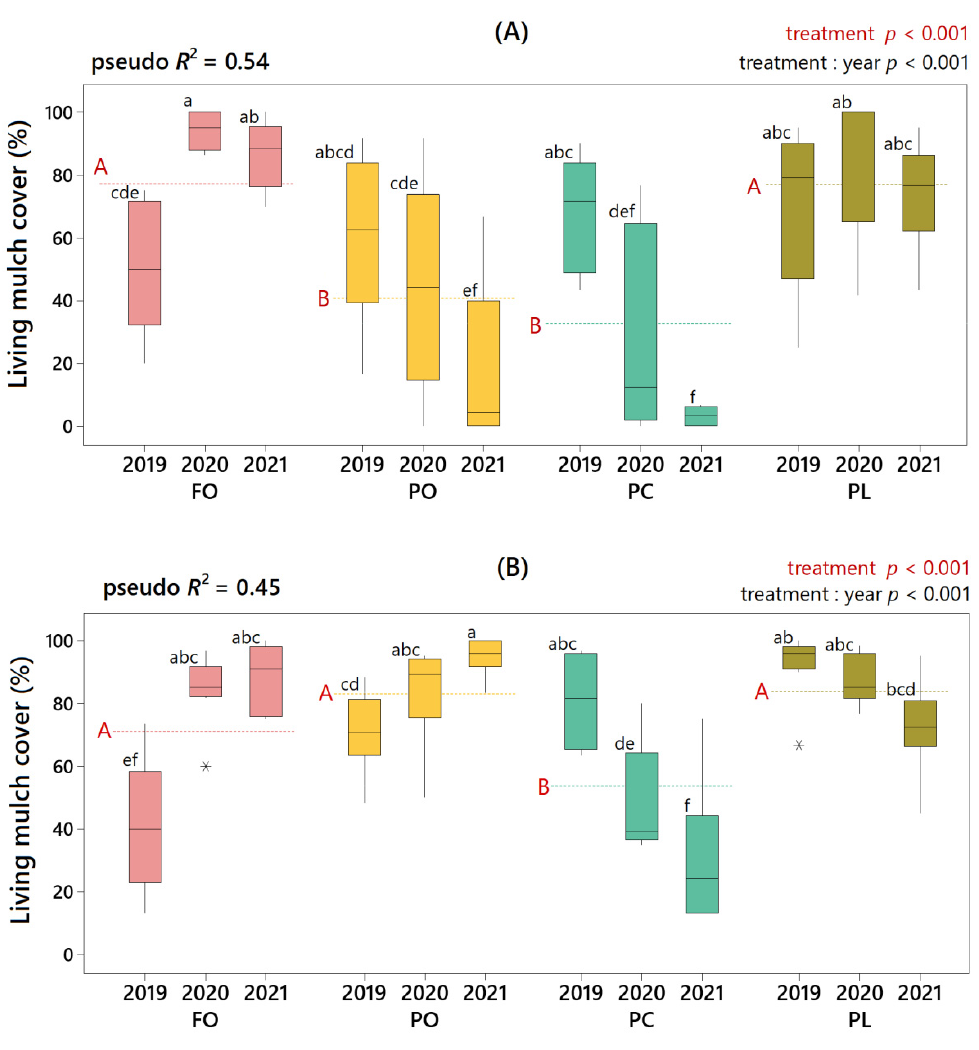
Figure 1. Living mulch cover (%) according to treatment and year on farm A ( A ) and farm B ( B ). Dashed lines mark the three-year mean for each treatment (FO, Festuca ovina living mulch; PO, Pilosella officinarum living mulch; PC, Plantago coronopus living mulch; PL, Plantago lanceolata living mulch). Significance levels ( p -values) of the factor “treatment” and of the interaction between “treatment” and “year” are indicated in the text in red and black ink, respectively. For the “treatment” level, means were significantly different if red capital letters next to the dashed lines are different. For the “treatment: year” level, boxes with different lower-case black letters had significantly different means. In the upper left corner, pseudo R 2 indicates the variance explained by the beta regression model.